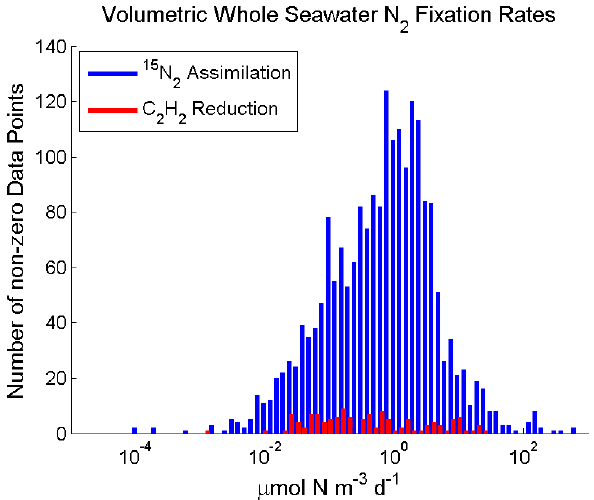
Figure 1. Histogram of volumetric, whole seawater N 2 fixation rates (non-zero values) from 15 N 2 assimilation assays and C 2 H 2 re- duction assays. Data values are on logarithmic